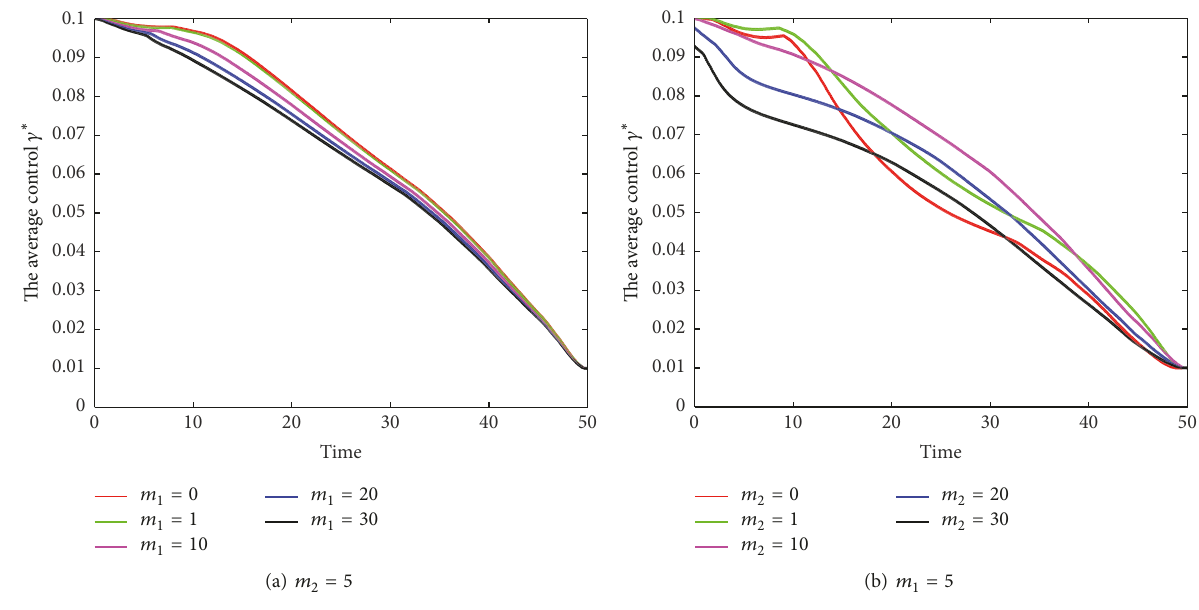
Figure 8: 𝛾 ∗ (𝑡) for different 𝑚 1 and 𝑚 2 for Example 2. Table 1: 𝐼 ∗ (𝑇) and 𝐽 under different control strategies with 𝑚 1 = 𝑚 2 = 2 for Example